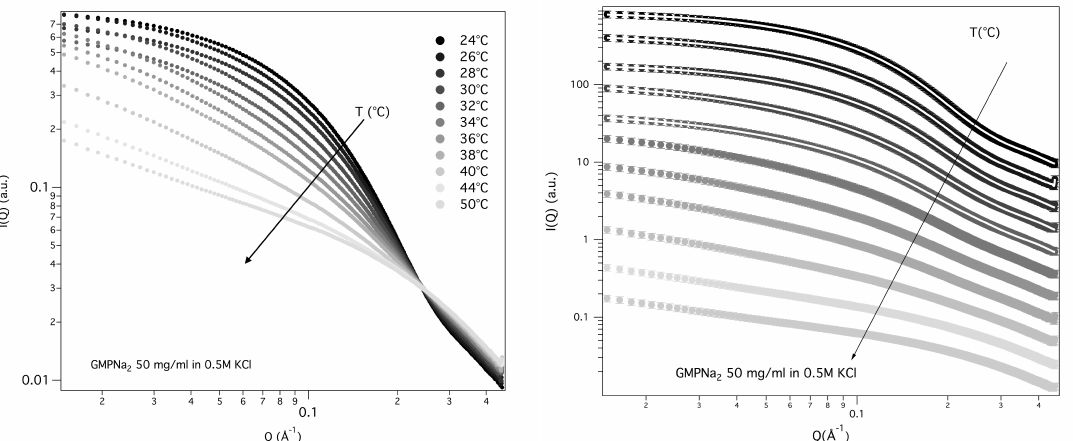
Figure 12. Temperature dependence of the SAXS curves for GMPNa 2 50 mg/mL in 0.5 M KCl. In the right panel, the curves are scaled for clarity, as the model fitting to the curves measured from 24 to 32 ◦ C is shown.